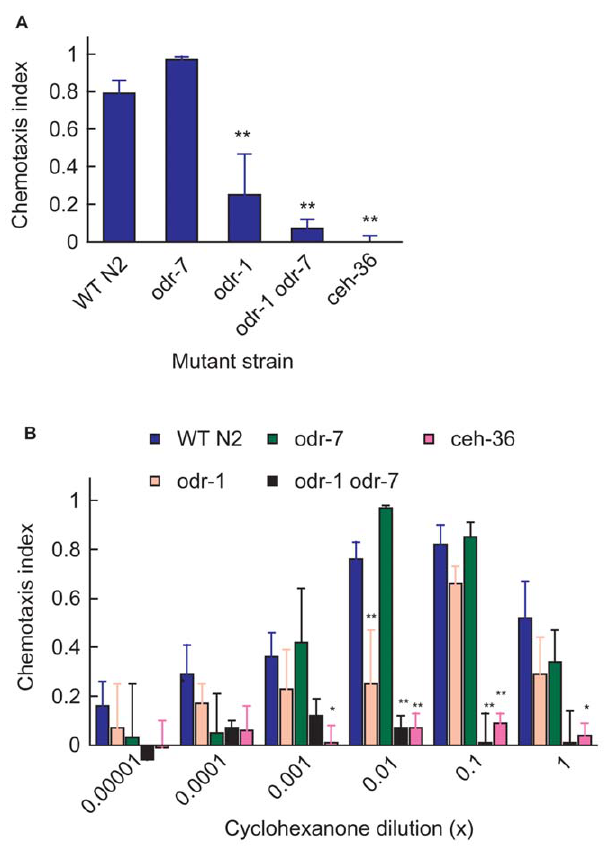
Figure. 2. The C.elegans chemotactic response to cyclohexa- none is primarily mediated via the AWC neurones. (A) Chemotactic responses of wild-type N2 and cell specific mutants odr- 7(ky4), odr-1(n1936), odr-1 ( n1936) odr-7(ky4) and ceh-36(ky646) to 1:100 cyclohexanone. (B) Log-concentration chemotactic responses of wild- type and cell specific mutants to cyclohexanone. N2 (blue), odr-1(n1936) (pink), odr-7(ky4) (green), odr-1(n1936) odr-7(ky4) (pink line), and ceh- 36(ky646) (purple line). Each bar represents the mean 6 sem of at least six (A) or four (B) independent assays. Statistics: * p , 0.05 and ** p , 0.01 in a one way ANOVA and Dunnett’s post test comparing all means to the wild-type (N2) mean.